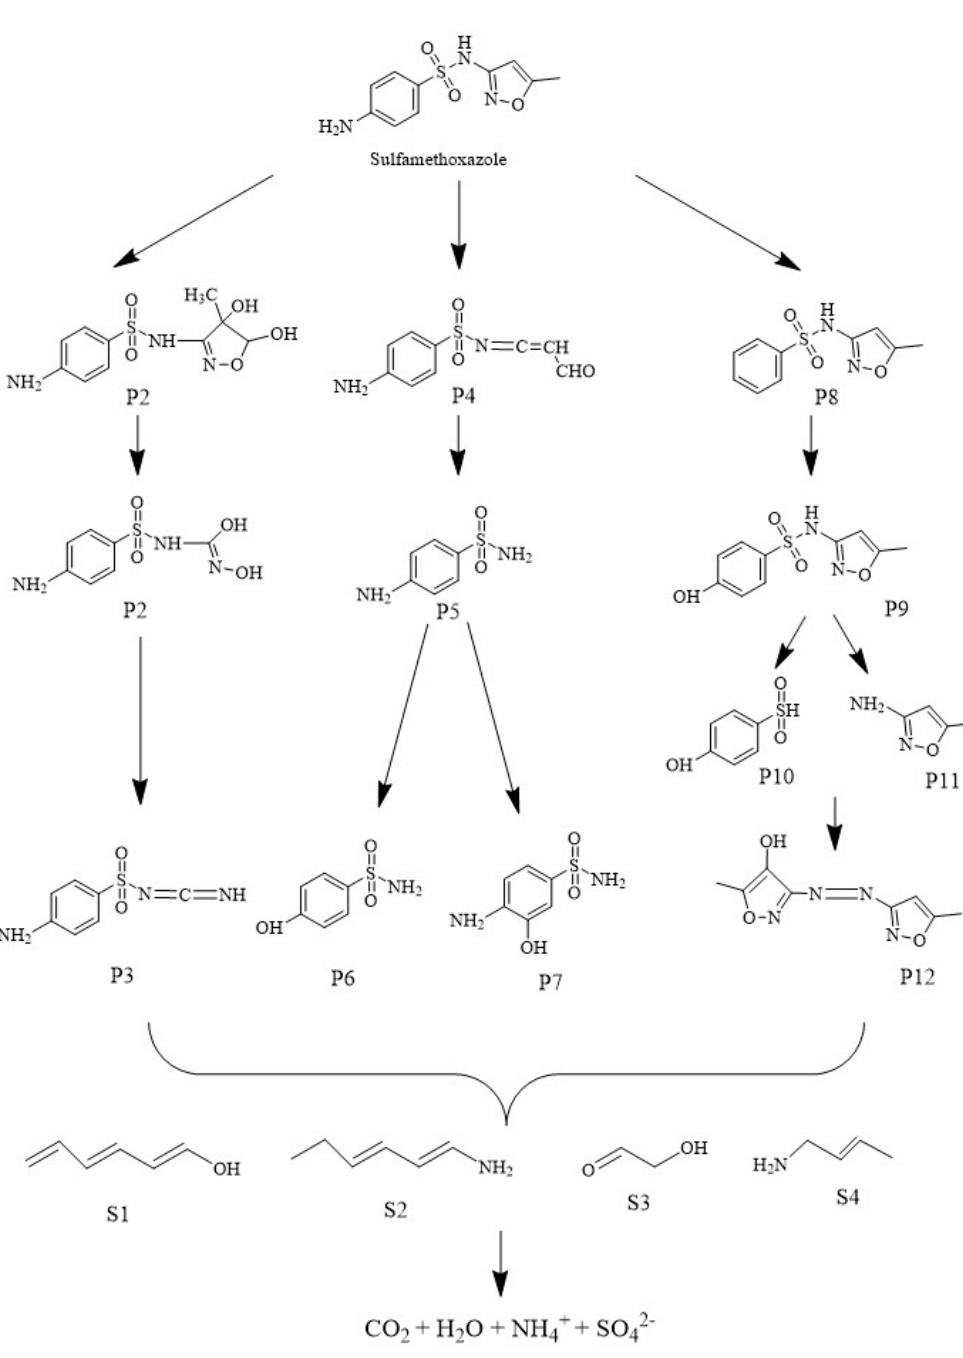
Figure 10. Proposed SMX degradation pathway in PEF process.